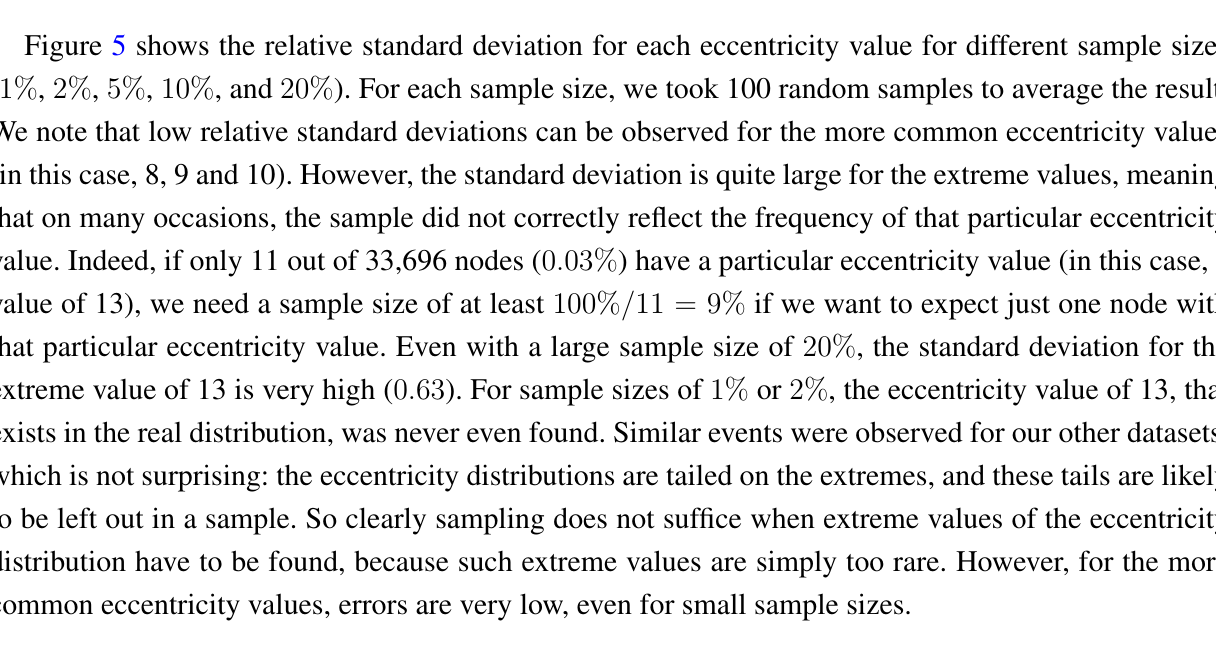
Figure 5. Relative standard deviation (vertical axis) vs . eccentricity value (horizontal axis) for different random sample sizes of the E NRON